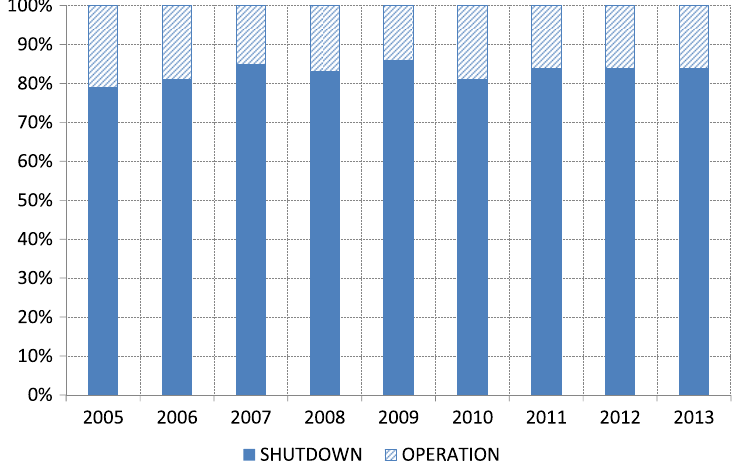
Fig. 2. Distribution of the French reactor fl eet collective doses for shutdown and operational phases [1].